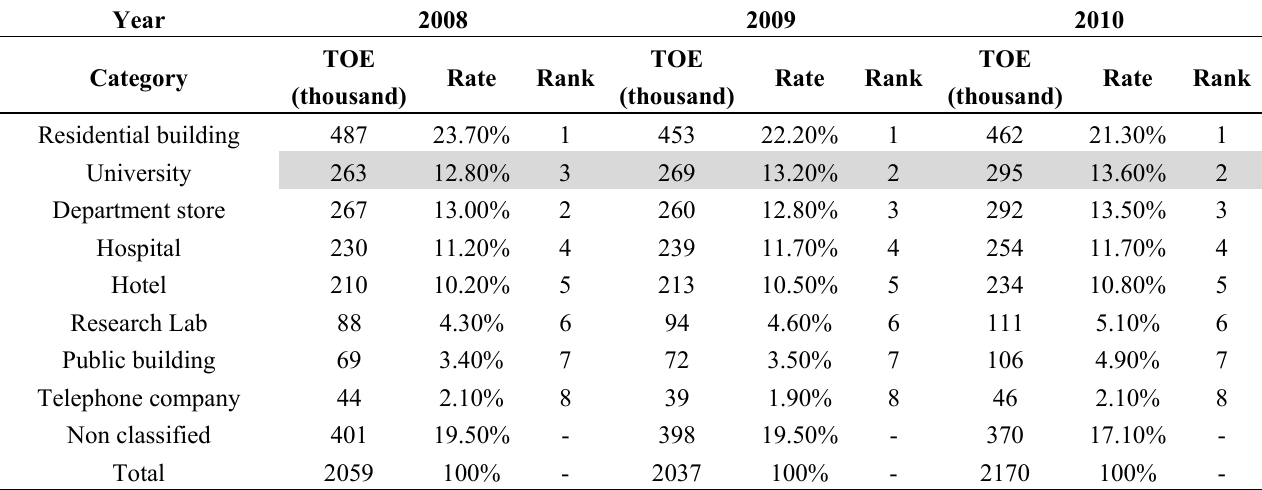
Table A2. Energy consumption by the types of buildings in South